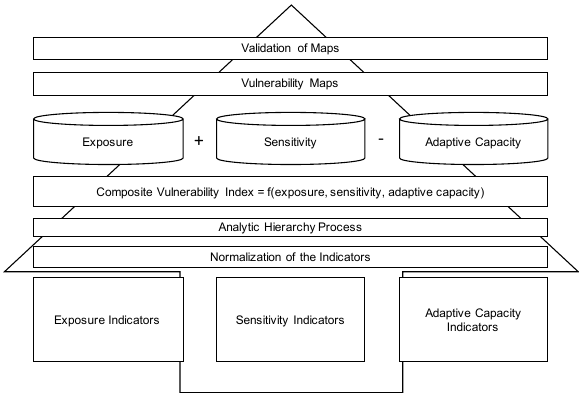
Figure 1. Methodological framework for vulnerability assessment employed in this